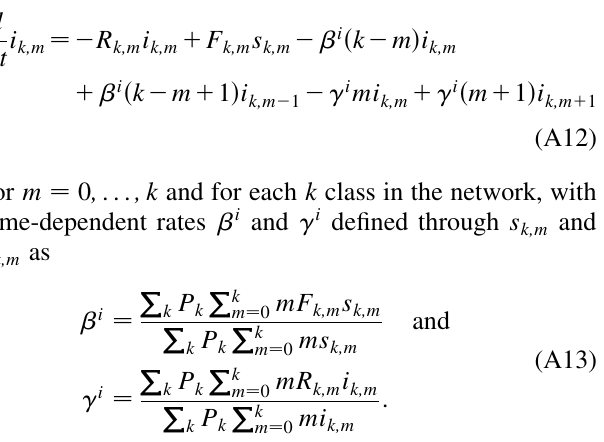
FIG. 9. Schematic of transitions to or from the S sets, as described in Eqs. (A5)–(A13). For each set, the central (ego) node is shown along with some of its neighbors: White nodes are susceptible or inactive or spin-down, and black nodes are infected or active or spin-up. See also Fig. 1 of Ref.